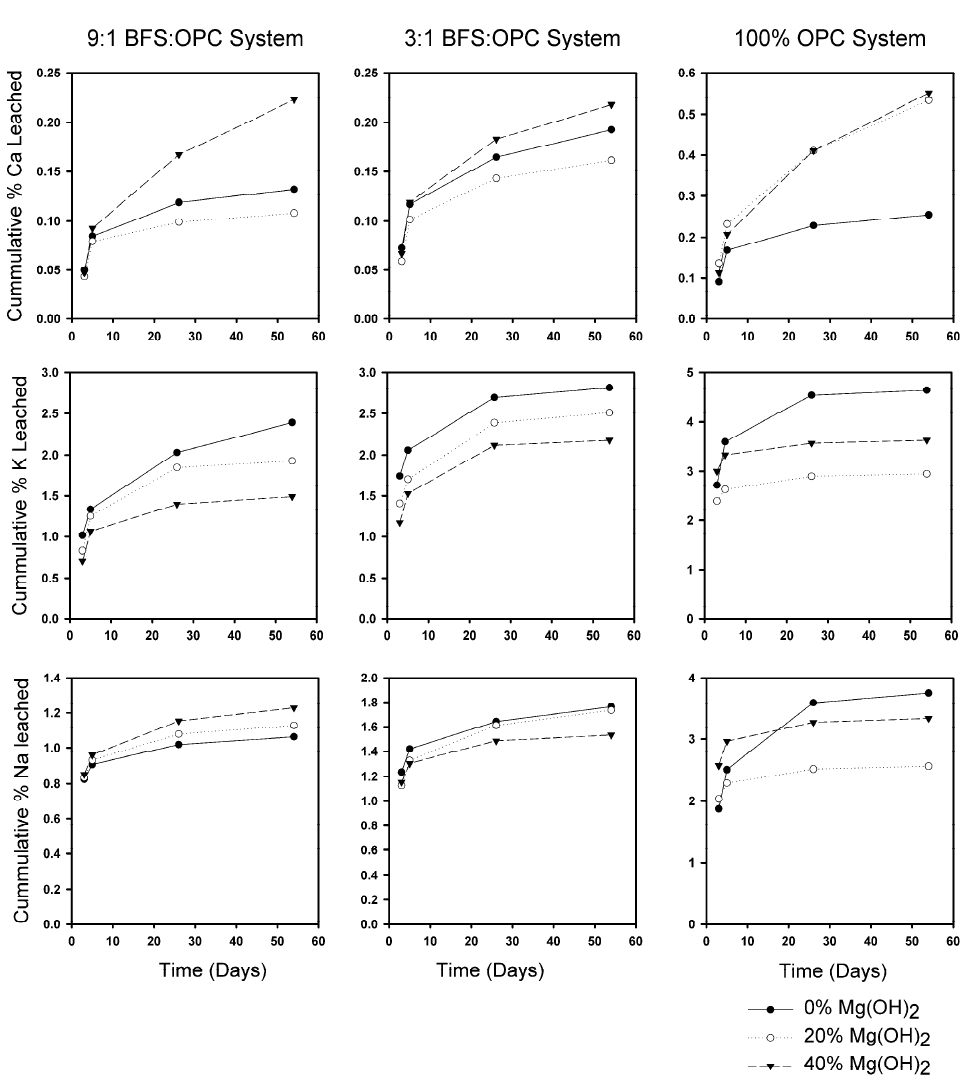
Figure 3. Stable element leaching data for 9:1 BFS:OPC, 3:1 BFS:OPC, and OPC systems with varying levels of Mg(OH) 2 .